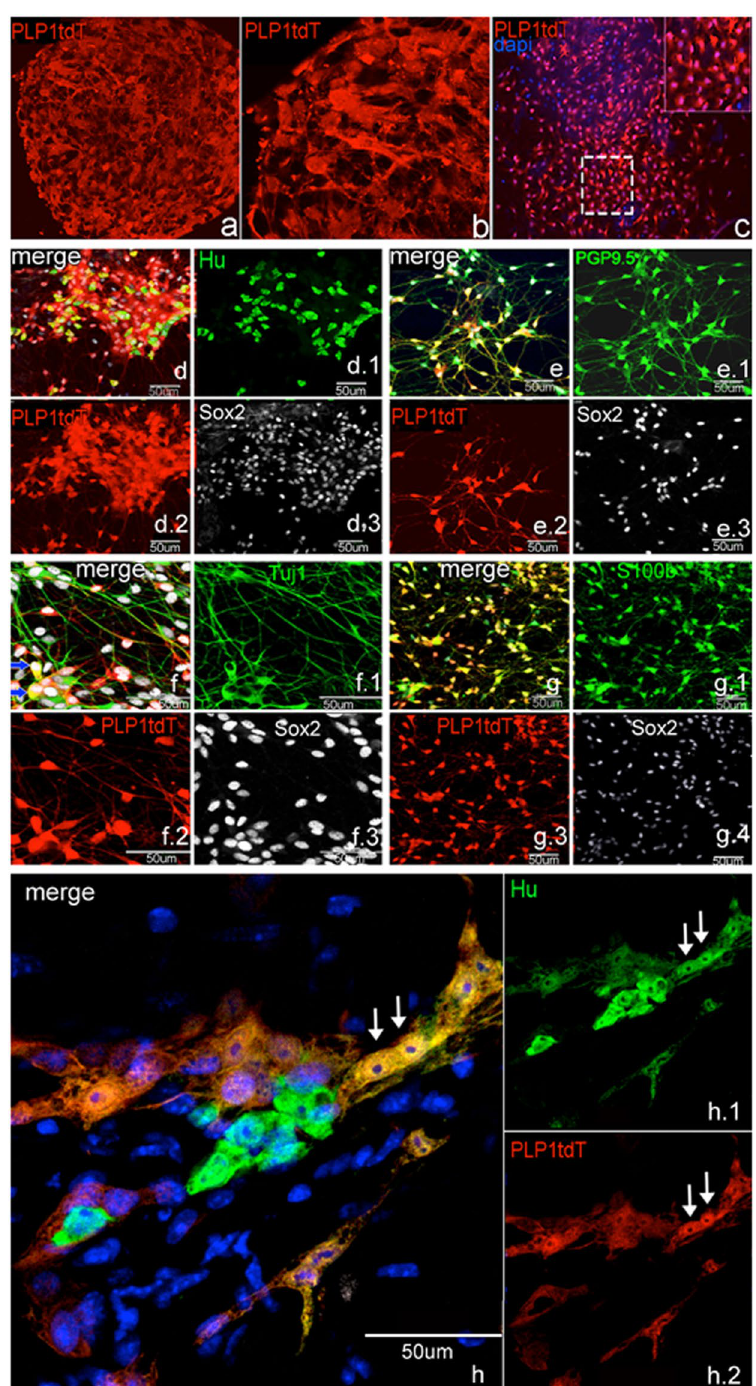
Figure 6. PLP1 + enteric glia give rise to neurons in vitro and ex vivo . Enteric neurospheres derived from PLP1CreER:tdT mice contain > 90% tdT + cells by confocal imaging ( a , b close up of boxed area in a ). The majority of cells dissociated from these neurospheres are tdT + ( c ). Following culture, PLP1CreER:tdT-derived cells are positive for Hu and Sox2 ( d ), PGP9.5 and Sox2 ( e ), Tuj1 and Sox2, (( f ) blue arrows denote triple-expressing cells), and S100b and Sox2 ( g ). Cultured colonic LMMP from PLP1CreER:tdT mice also shows tdT + /Hu + double- expressing cells ( h , arrows). All images of Fig. 6 were taken at 100X except closeup. (5 b and f , h at